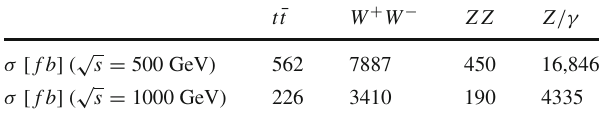
Table 4 Background cross sections